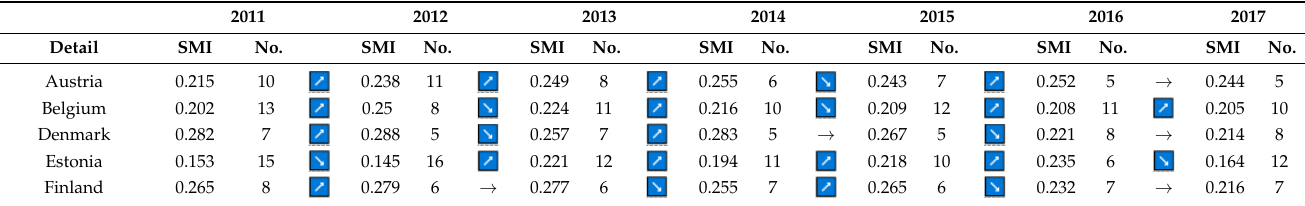
Table A2. Result of a multivariate analysis of the environmental effectiveness of R&D spending in the energy sector from 2011 until 2017/2019.